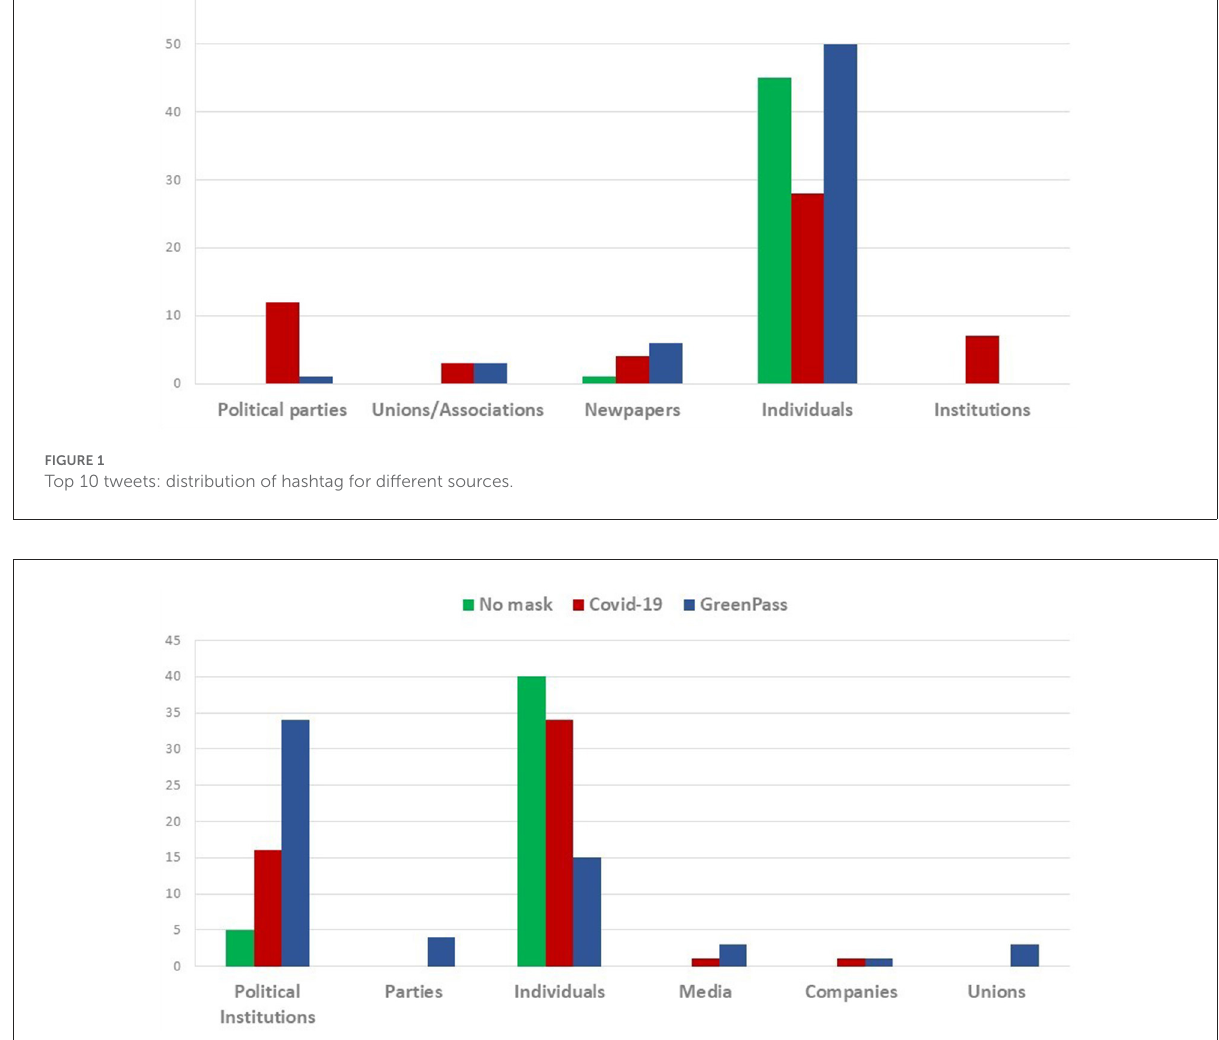
FIGURE2 Top 10 tweets: distribution of hashtag for different